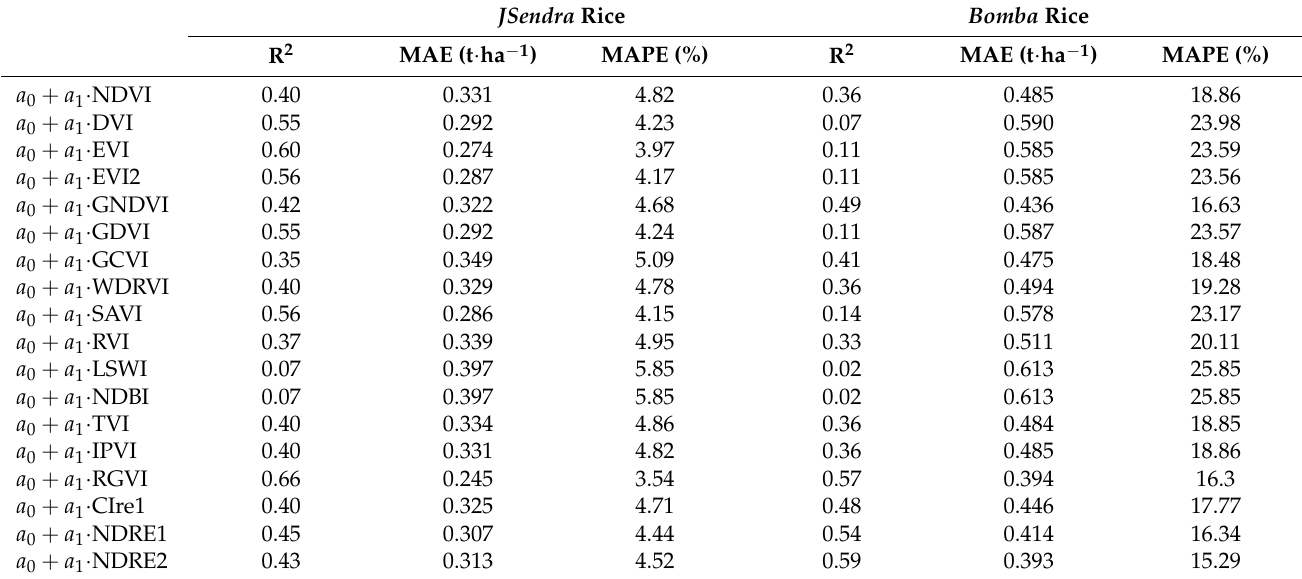
Table A6. Performance metrics of the VIs-based models considering the training dataset at 20 m spatial resolution. JSendra